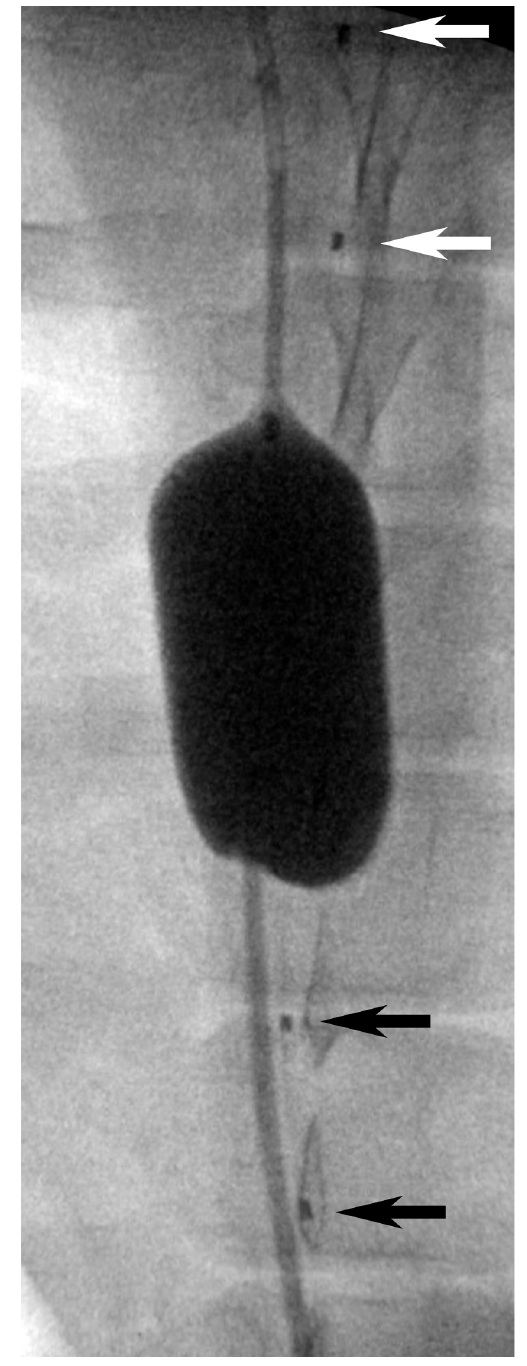
Fig 3. Anterior-posterior radiograph of an REOBA balloon. The balloon was inflated in the aorta between the caudal (black arrows) and central (white arrows) positions of a FLOXsp probe placed on the along the spinal cord in the epidural space. Fiducial markers noted by arrows are located between each light source and corresponding pair of detector positions (Fig 1).